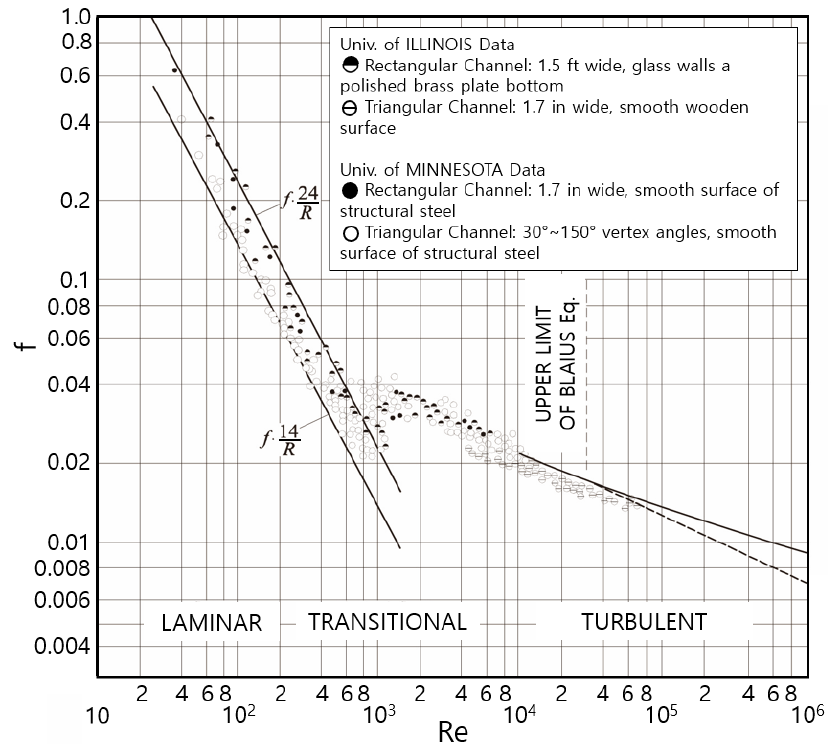
Figure 1. Relationship between f and Re for smooth channels (Flow conditions: Laminar, Transitional, and Turbulent [15]).